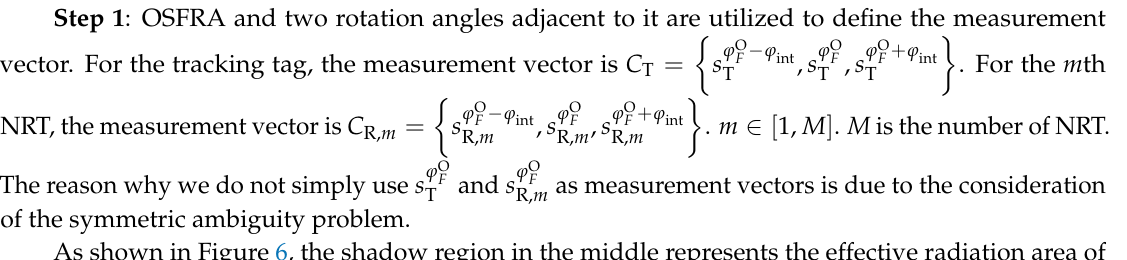
Figure 6. Schematic diagram of the symmetric ambiguity problem.